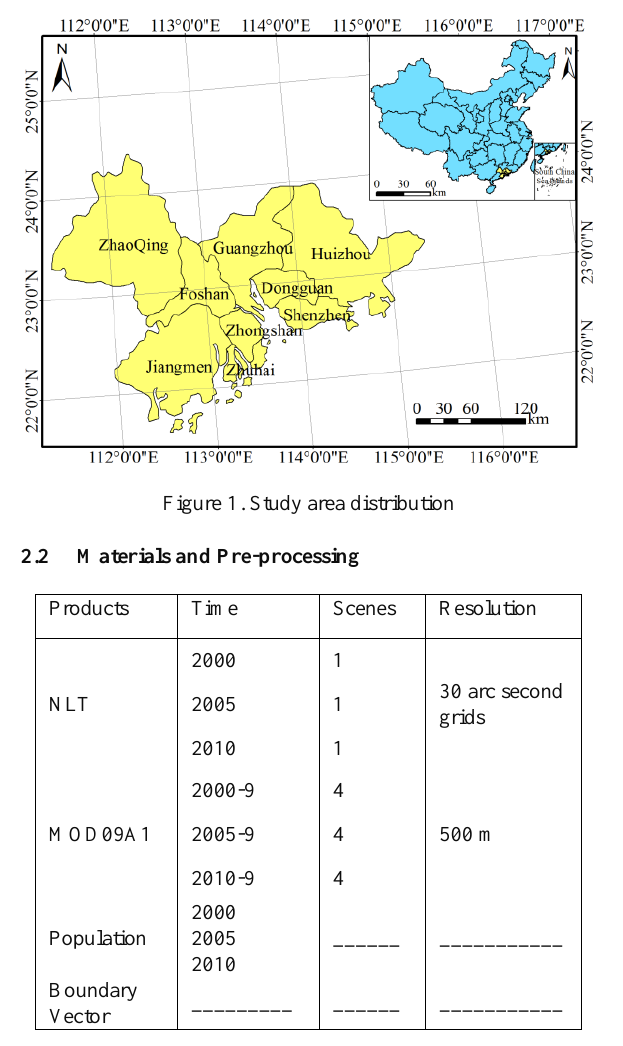
Table 1. Datasets used in this